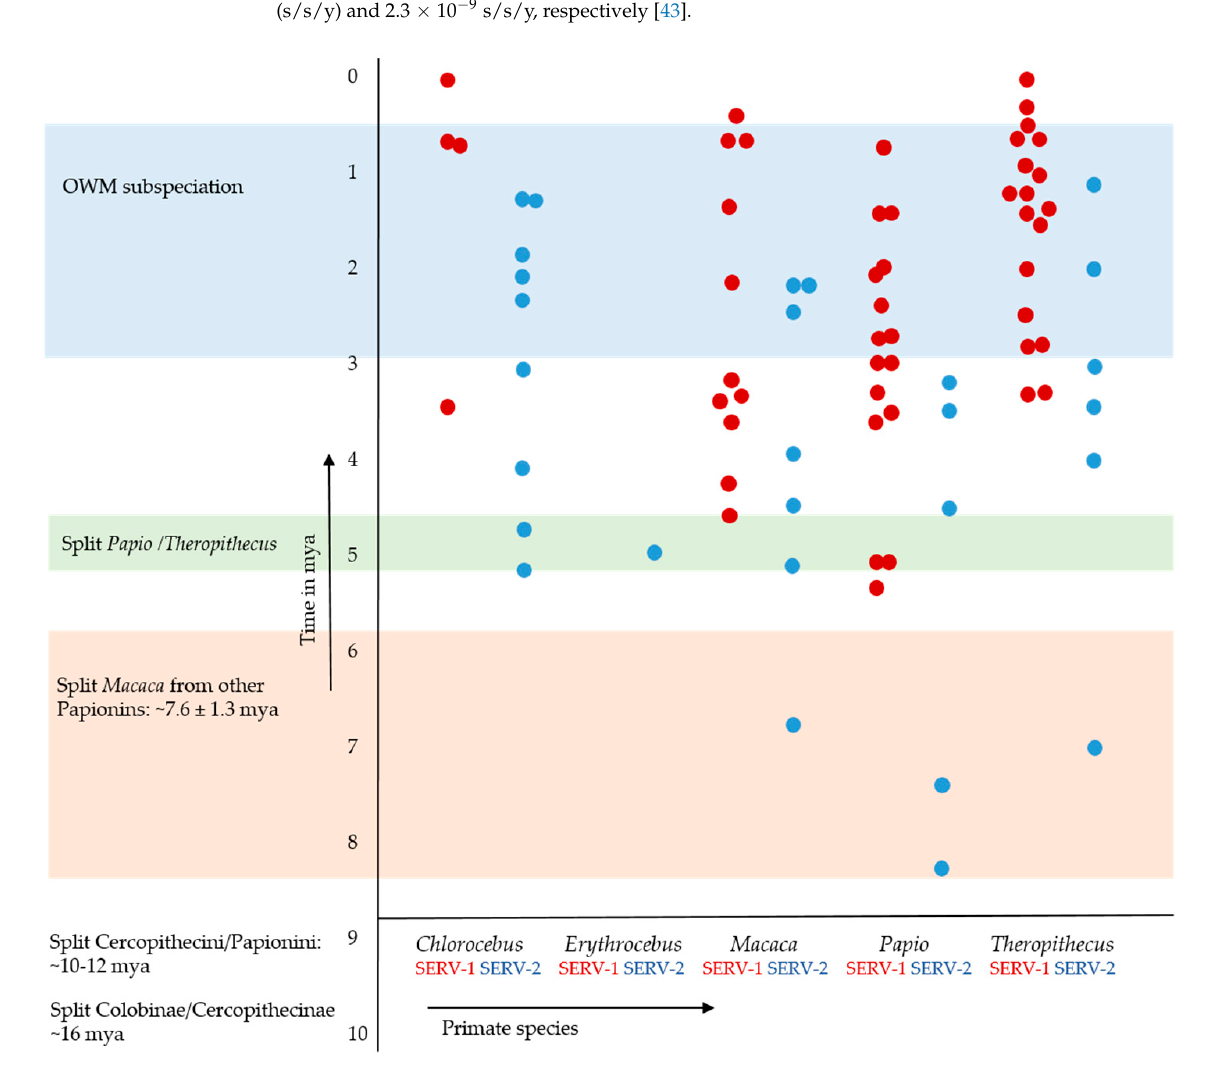
1 Determined using MEGA X, with Kimura-2-parameter distances, γ -distributed, homogeneous rates among lineages, and pair-wise deletion for gaps/missing data [13] . 2 T = K/2r, whereby r = 5 ×